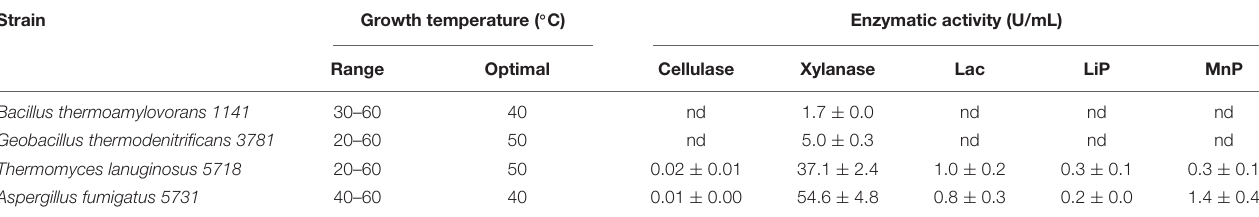
TABLE 4 | Production of enzymes by selected thermophilic isolates.